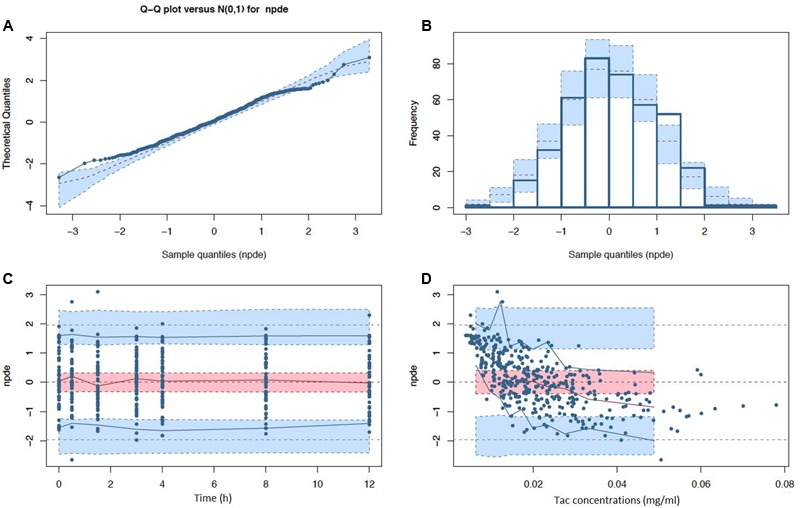
Normalized prediction distribution error (npde) diagnostic plots (A) Q-Q plot and (B) histogram with expected normal distributions indicated by the dashed lines and light blue boxes (mean and CI95% ranges) and (C) npde with respect to post-intake time (D) and predicted Tac concentration with observed (solid lines) and expected (dashed lines) npde means (red), 5th and 95th percentiles (blue) with their corresponding CI95% (filled ranges).